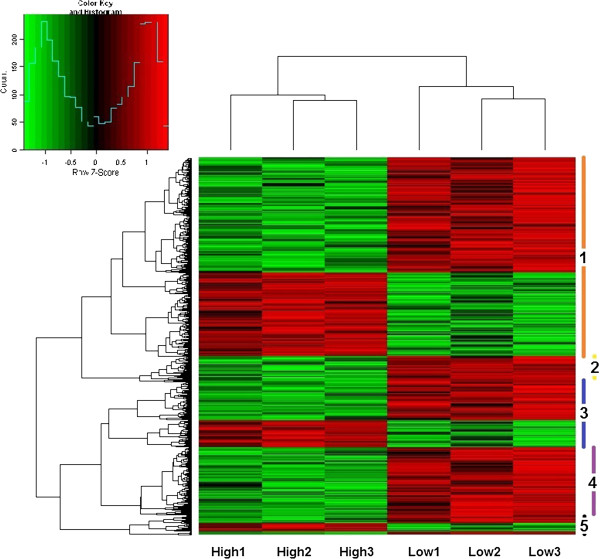
Hierarchical clustering of all differentially expressed genes. Colors indicate up- (red) or down- (green) regulation. Designation of clusters from 1 to 5 is displayed at the right.